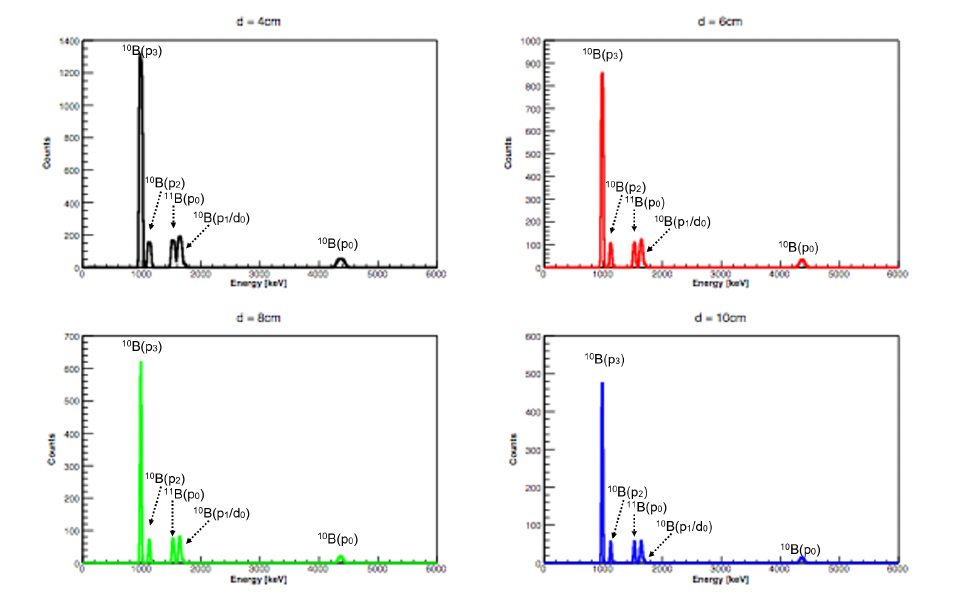
Figure 6: Spectrum of charged particle detected by silicon detector at 120 ◦ . Target thickness is 10 µ m / cm 2